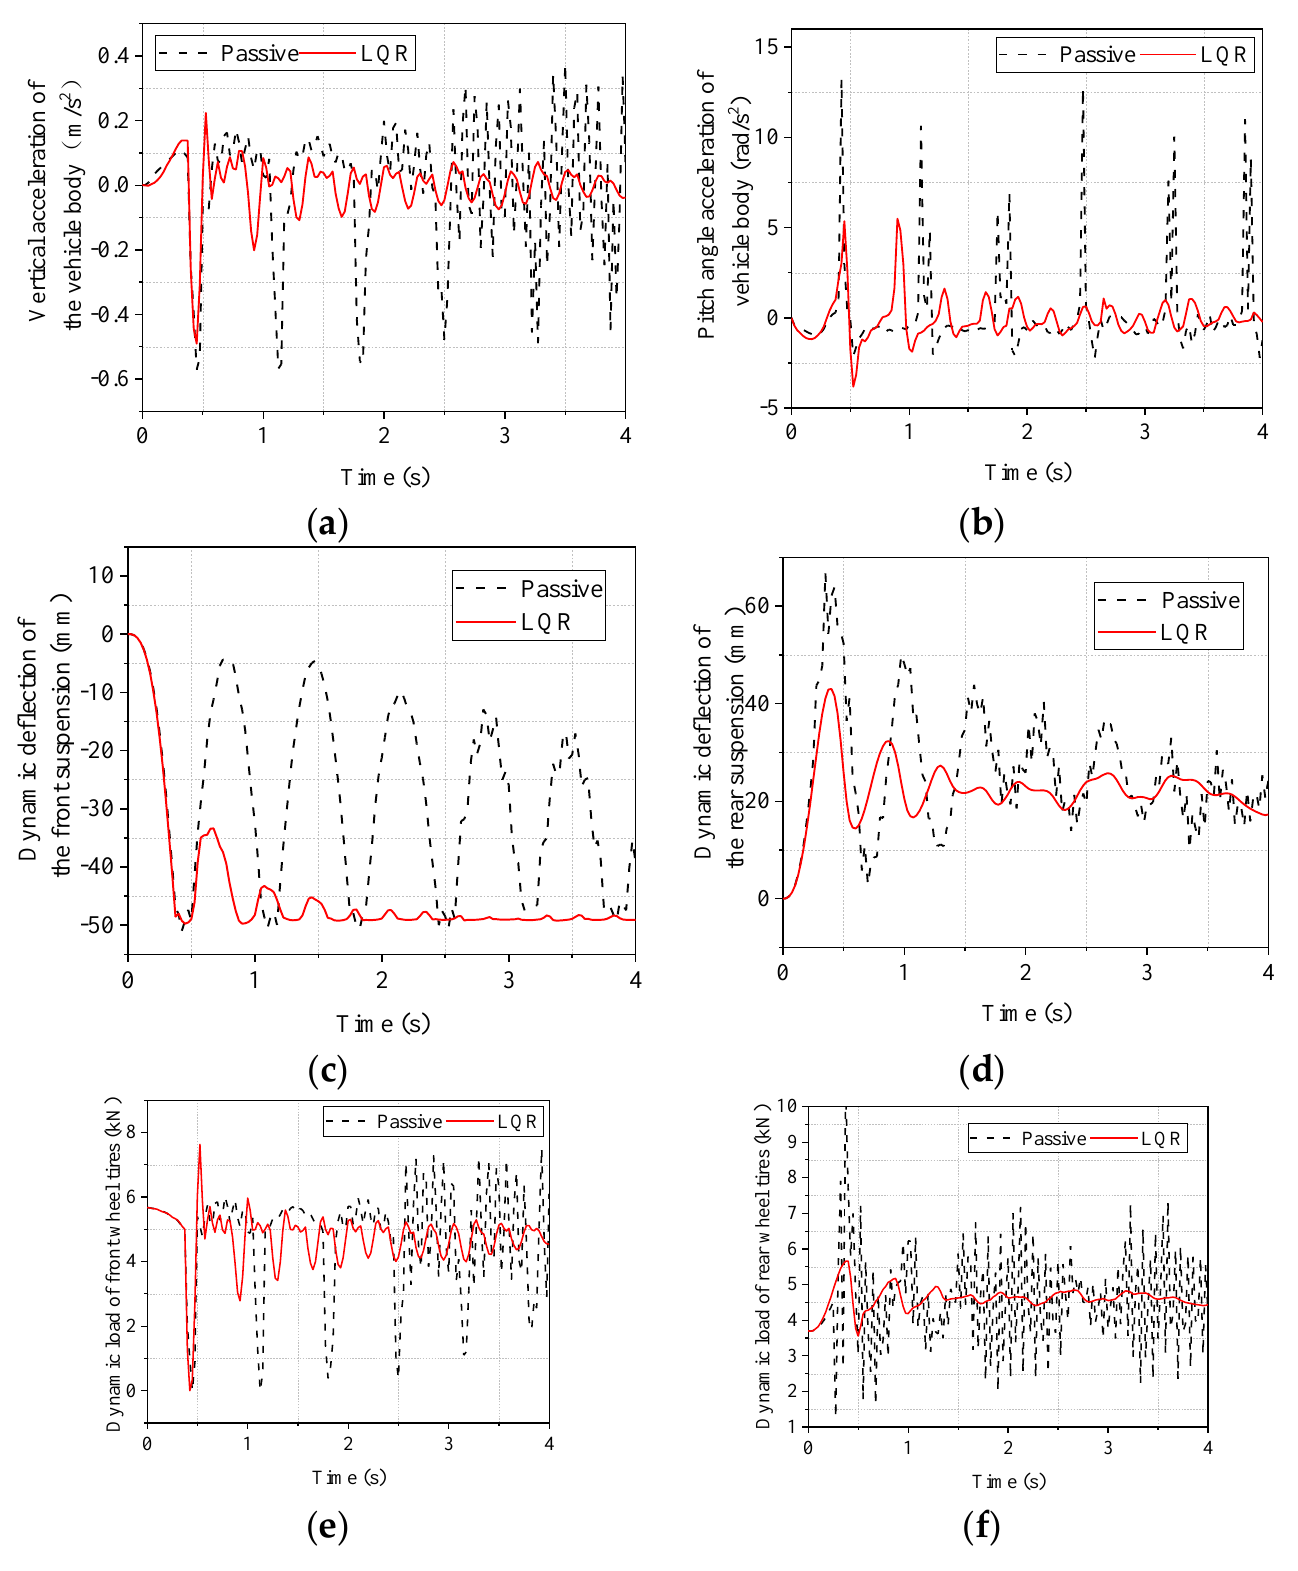
Figure 12. Simulated time domain response of emergency acceleration condition. ( a ) body vertical acceleration; ( b ) body pitch angle acceleration; ( c ) front suspension dynamic deflection; ( d ) rear suspension dynamic deflection; ( e ) front wheel tire dynamic load; ( f ) rear wheel tire dynamic load.